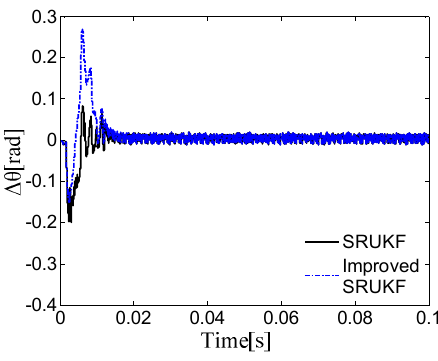
Figure 16. Space position estimation error at parameters disturbance.